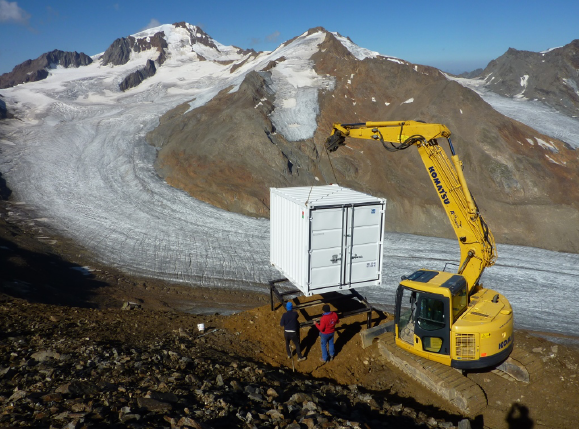
Figure 1. Installation of the TLS container in September 2016. The snow covered mountain top on the left side is Weißkugel